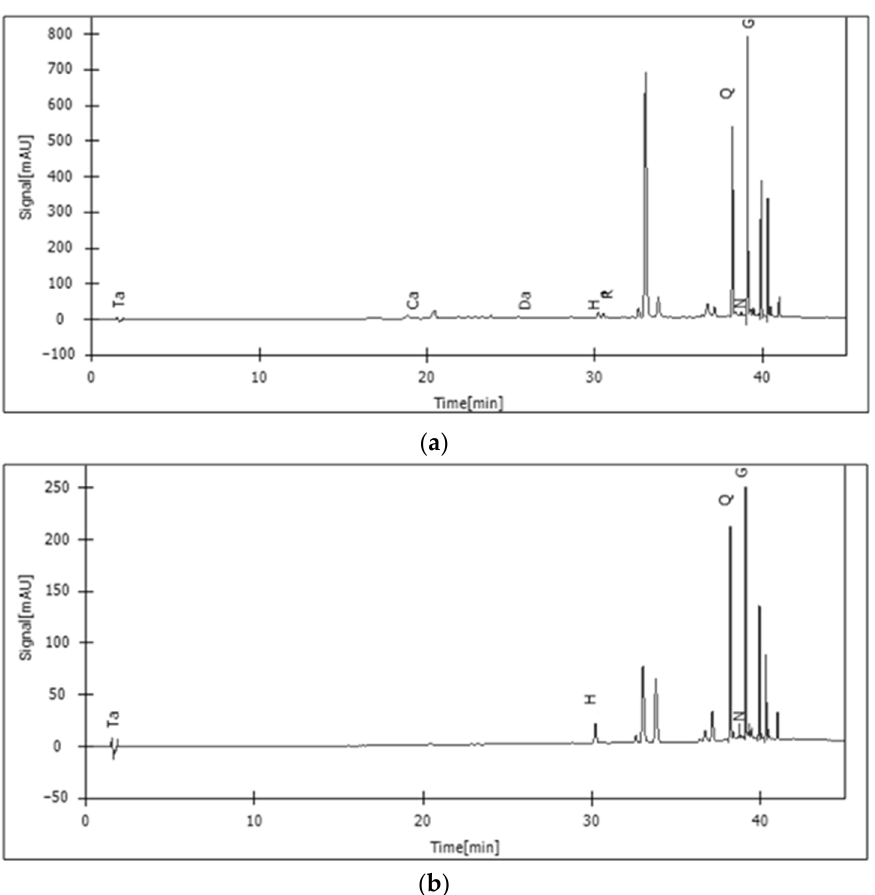
Figure 3. HPLC–DAD chromatograms of the samples: ( a ) A. foeniculum - methanolic extract